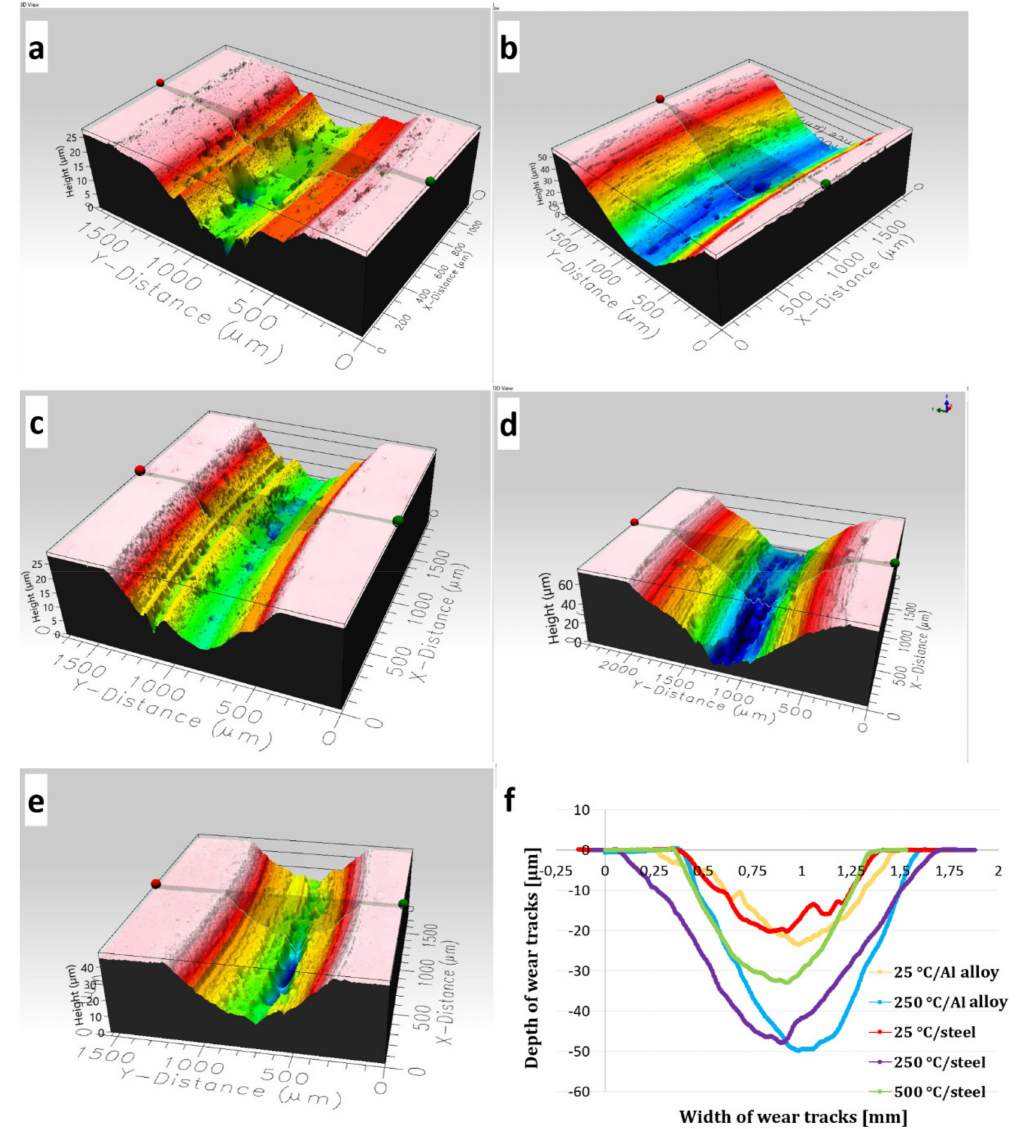
Figure 13. The surface topography of wear tracks of the (Cr 3 C 2 -25(Ni20Cr))-(Ni25C) coatings tested under 20 N load; coating on the Al alloy, 25 ◦ C ( a ), coating on the Al alloy, 250 ◦ C ( b ), coating on steel, 25 ◦ C ( c ), coating on steel, 250 ◦ C ( d ), coating on steel, 500 ◦ C ( e ), and depth vs. width of the deposit wear tracks ( f